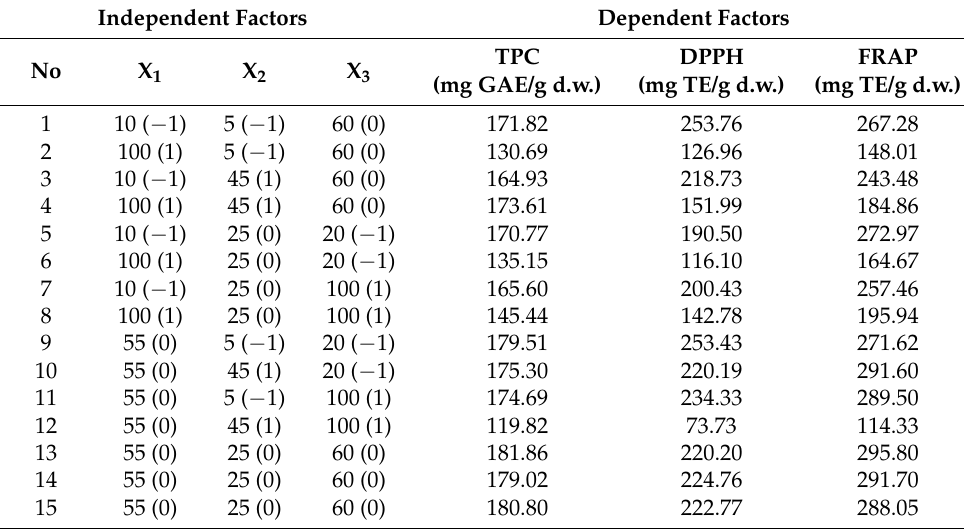
Table 1. Box–Behnken experimental design including the natural and coded (in parenthesis) values of the extraction conditions and the experimental results for TPC, DPPH and